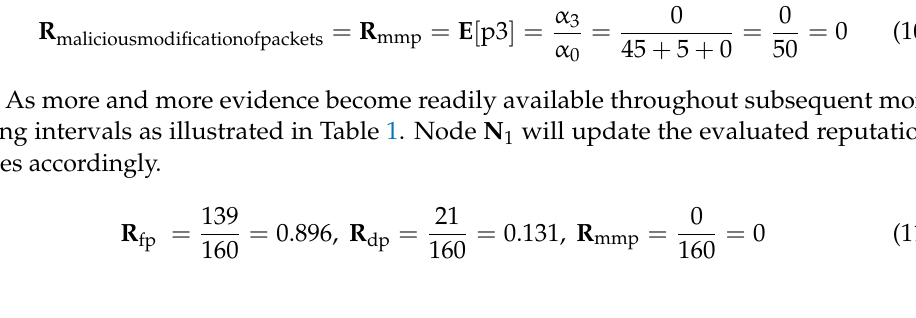
Table 1. Observed packet transmission activities over four defined monitoring